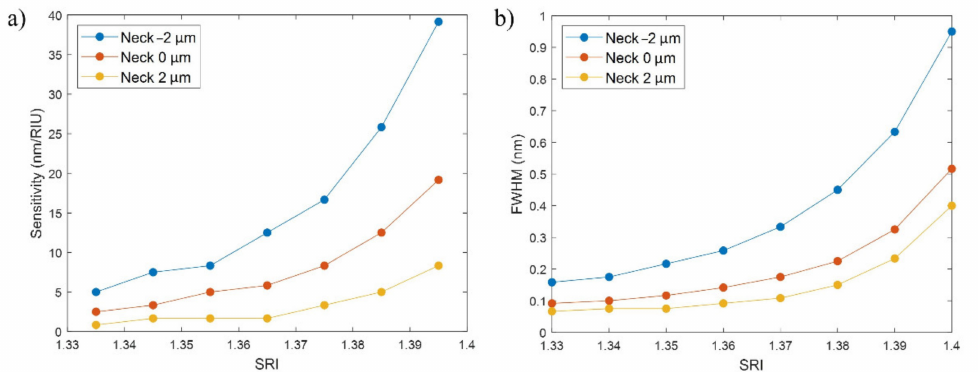
Figure 8. ( a ) Sensitivity to the SRI (nm/RIU) vs. SRI (RIU), and ( b ) FWHM (nm) vs. SRI (RIU), for a thin-film thickness of 125 nm and necks of − 2, 0, and 2 µ